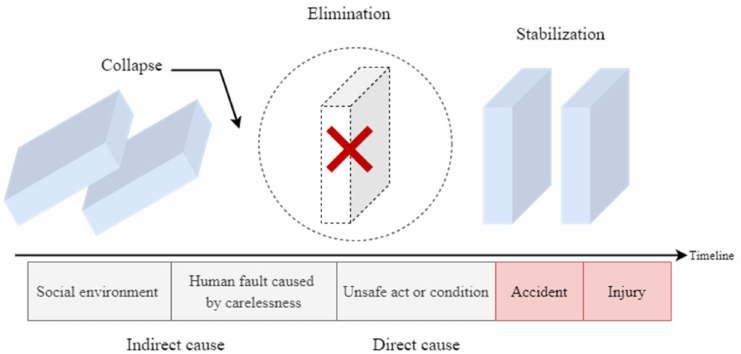
Figure 1. Heinrich’s Domino Model of Accident